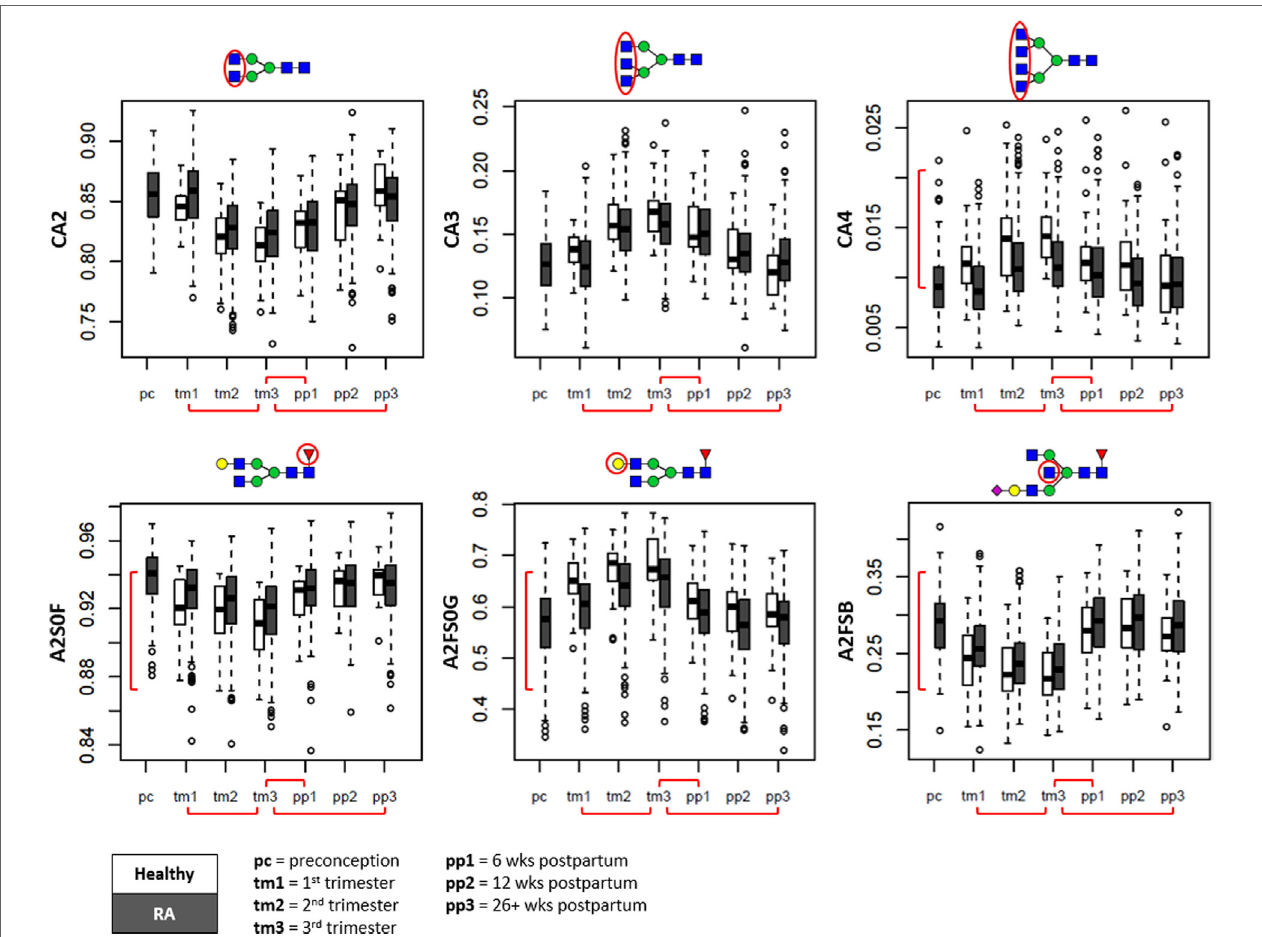
FigUre 3 | Overall glycosylation changes throughout pregnancy and the postpartum period shown in boxplots. Displayed are the glycan traits related to antennarity ( top row ), and the glycosylation traits likely to be of immunoglobulin origin ( bottom row ) (15, 26). Depicted are healthy controls (in white) and patients with rheumatoid arthritis (RA) (in gray) at preconception (pc), trimesters 1 through 3 (tm1, tm2, tm3), 6 weeks postpartum (pp1), 12 weeks postpartum (pp2), and 26 + weeks postpartum (pp3). CA2, diantennary species within complex type; CA3, triantennary species within complex type; CA4, tetraantennary species within complex type; A2S0F, fucosylation of non-sialylated diantennary species; A2FS0G, galactosylation of non-sialylated fucosylated diantennary species; A2FSB, bisection of sialylated fucosylated diantennary species. Red brackets indicate statistically significant findings between time points (horizontal), or between healthy individuals and RA patients